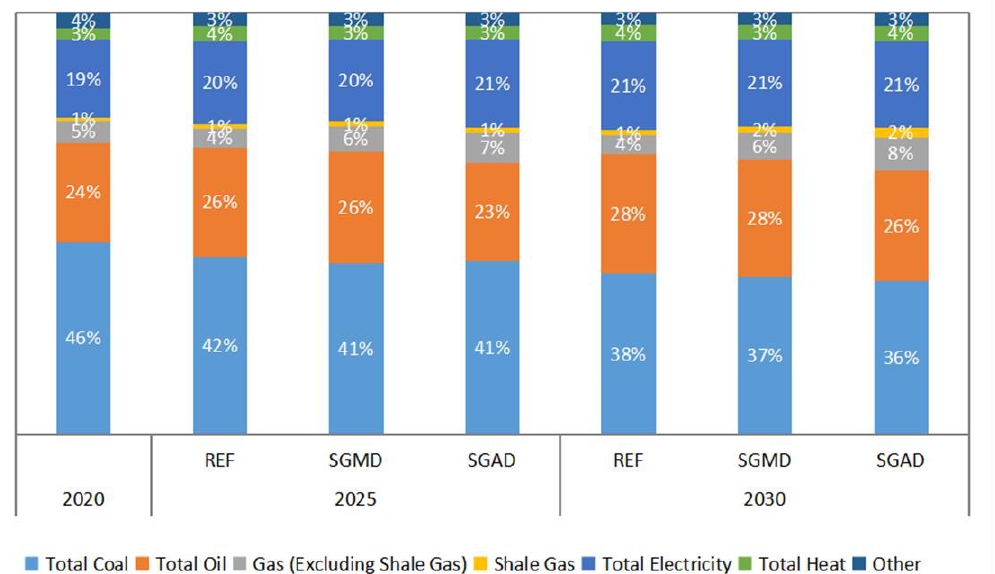
Figure 5. Final energy consumption structure.